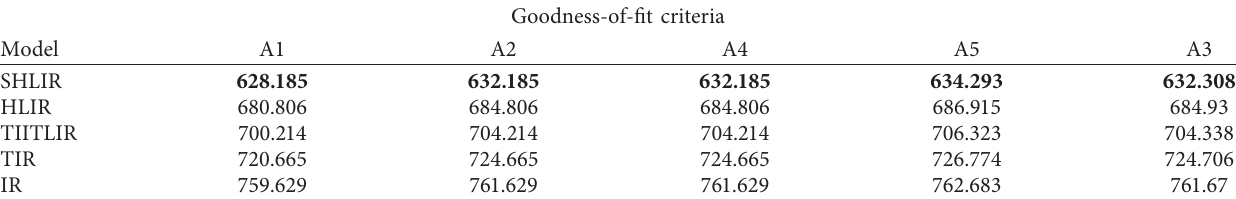
Table 6: The values of A1, A2, A3, A4, and A5 for data II. Goodness-of-fit